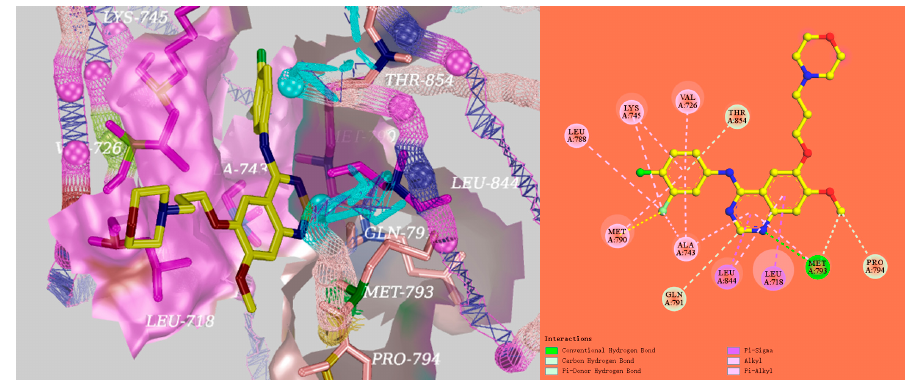
Figure 4. The 3D and 2D representation of the EGFR crystal structure in complex with gefitinib (PDB ID: 4I22). ( left ) The 3D representation of the EGFR crystal structure in complex with gefitinib; ( right ) The 2D representation of the EGFR crystal structure in complex with gefitinib.